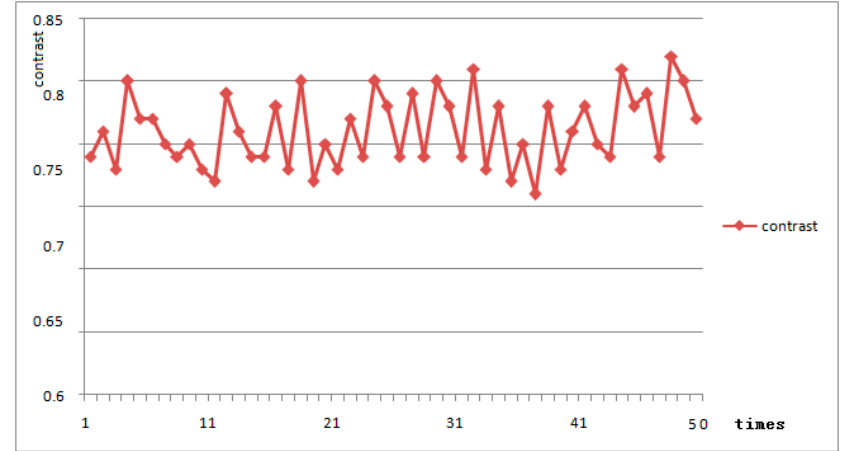
Figure10. Fingerprint imaging contrast. Figure 10. Fingerprint imaging